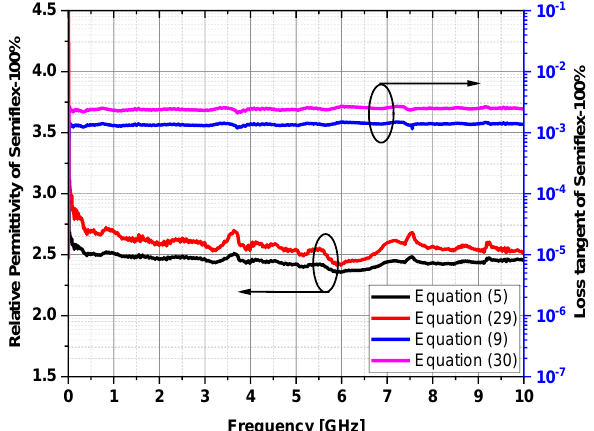
Figure 9. Relative permittivity and loss tangent of the semi-flex measured with the circular coaxial fixture.